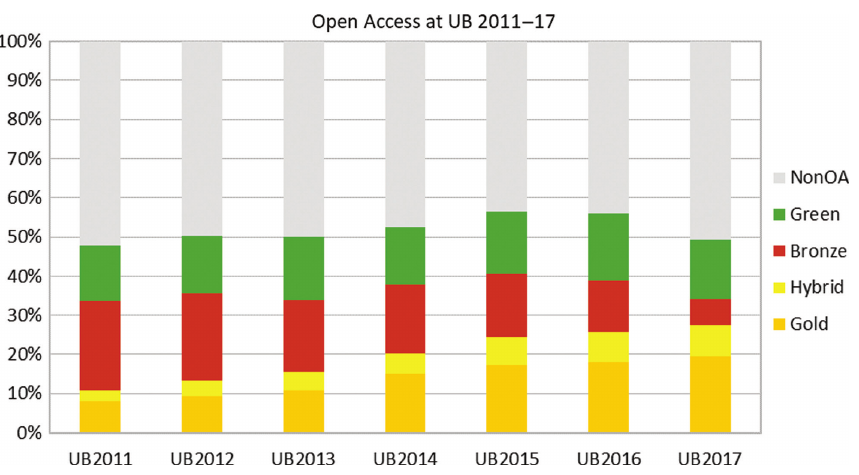
Fig. 1: Open Access situation at UB 2011–2017. Analysis of the research publications from 2011 to 2017. Results obtained in June 2018.